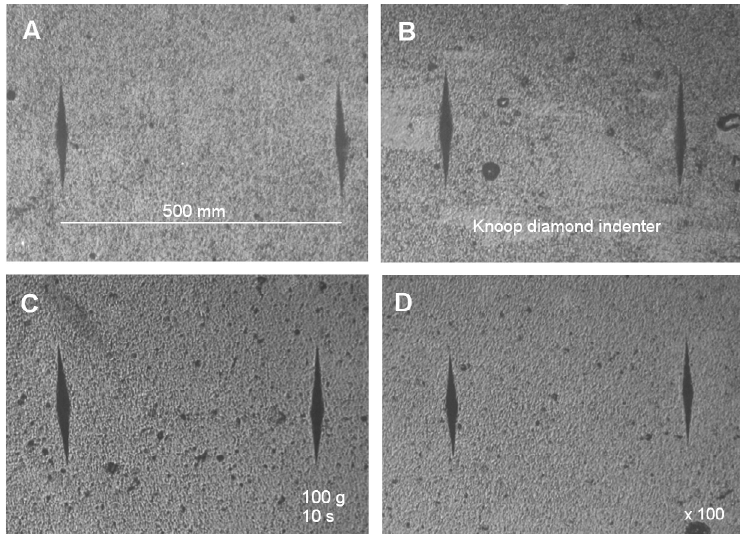
Figure 1- Photomicrographs of surface hardness test according to the groups at the 7 th day: A: Control; B: 1% CaGP; C: 3% CaGP and D: 9% CaGP (x100 magnification)